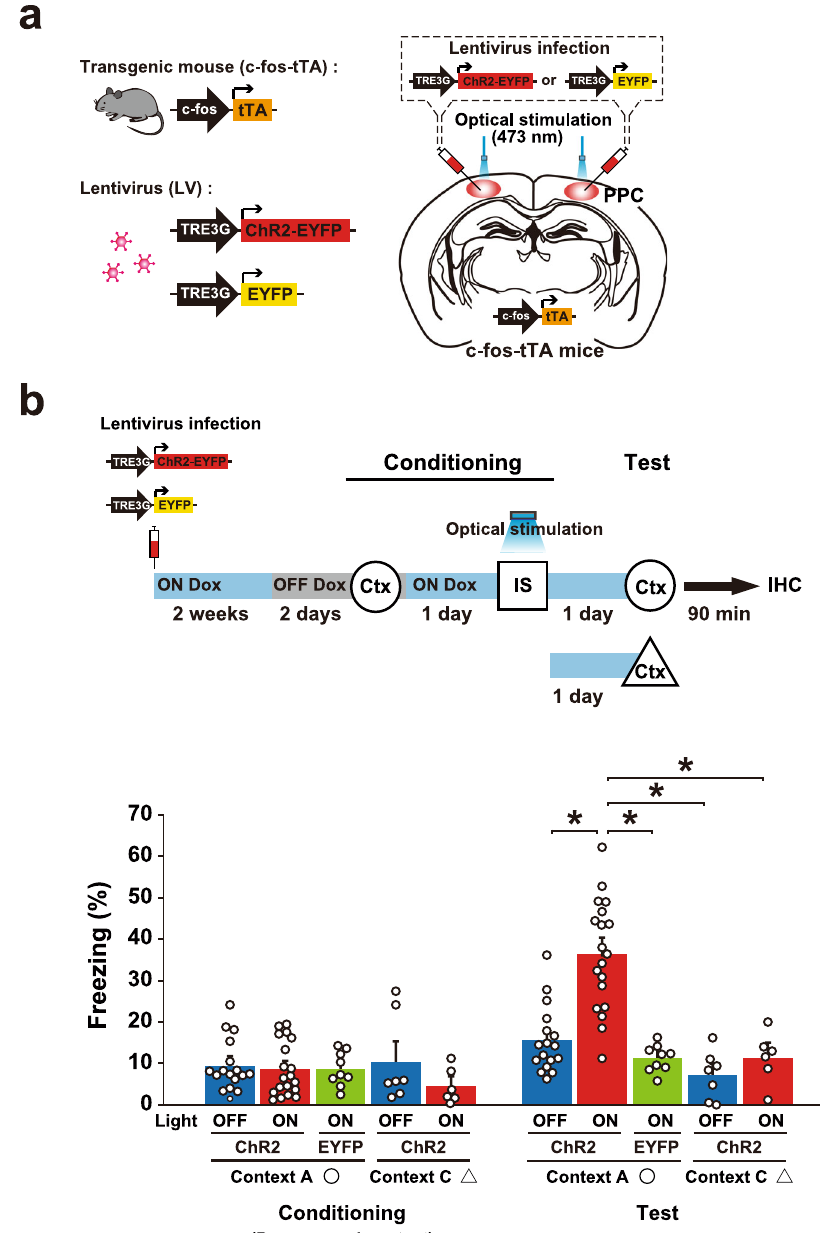
Fig. 3 Optical activation of the PPC cell ensemble generates an arti fi cial pre-exposed context-IS associative memory. a Labeling of the PPC neurons in c-fos-tTA transgenic mice with the LVs TRE3G-ChR2-EYFP or TRE3G-EYFP. b Activating cell ensembles during an IS session of conditioning (top). The blue and gray bars indicate the presence or absence of Dox, respectively. The graph shows freezing level in context A or C in the conditioning and test session (bottom) (ChR2-Light OFF in circle, n = 17 mice, ChR2-Light ON in circle, n = 19 mice, EYFP-Light ON in circle, n = 9 mice, ChR2-Light OFF in triangle, n = 7 mice, ChR2-Light ON in triangle, n = 6 mice) (two-way ANOVA with RM followed by Sidak ’ s post hoc test, session: P < 0.0001, group: P < 0.0001, session × group: P < 0.0001). Mice were sacri fi ced 90 min after the test for immunohistochemistry (Fig. 6c, d). Error bars represent the mean ± s.e.m. * P < 0.05. Ctx context, IS immediate shock, IHC immunohistochemistry. For details of statistical data, see Supplementary Table 1. Source data are provided as a Source Data fi of the TGB plasmid 46 , generating a pLenti-TRE3G-ChR2-EYFP plasmid. The above lentiviral plasmids were prepared using an EndoFree Plasmid Maxi kit (Qiagen, Hilden, Germany) and were used for the LV preparation as described previously 23 . The 293FT cells (Invitrogen) were maintained in maintenance medium (Dulbecco ’ s modi fi ed Eagle ’ s medium; Gibco, 11995) containing 10% heat-inactivated fetal bovine serum, 2 mM L -glutamine (Gibco, 25030-149), 0.1mM MEM non-essential amino acids (Gibco, 11140-050), 500 μ g/ml geneticin (Gibco, 10131-035), and 1% 100× penicillin/streptomycin (Gibco, 15140-148).